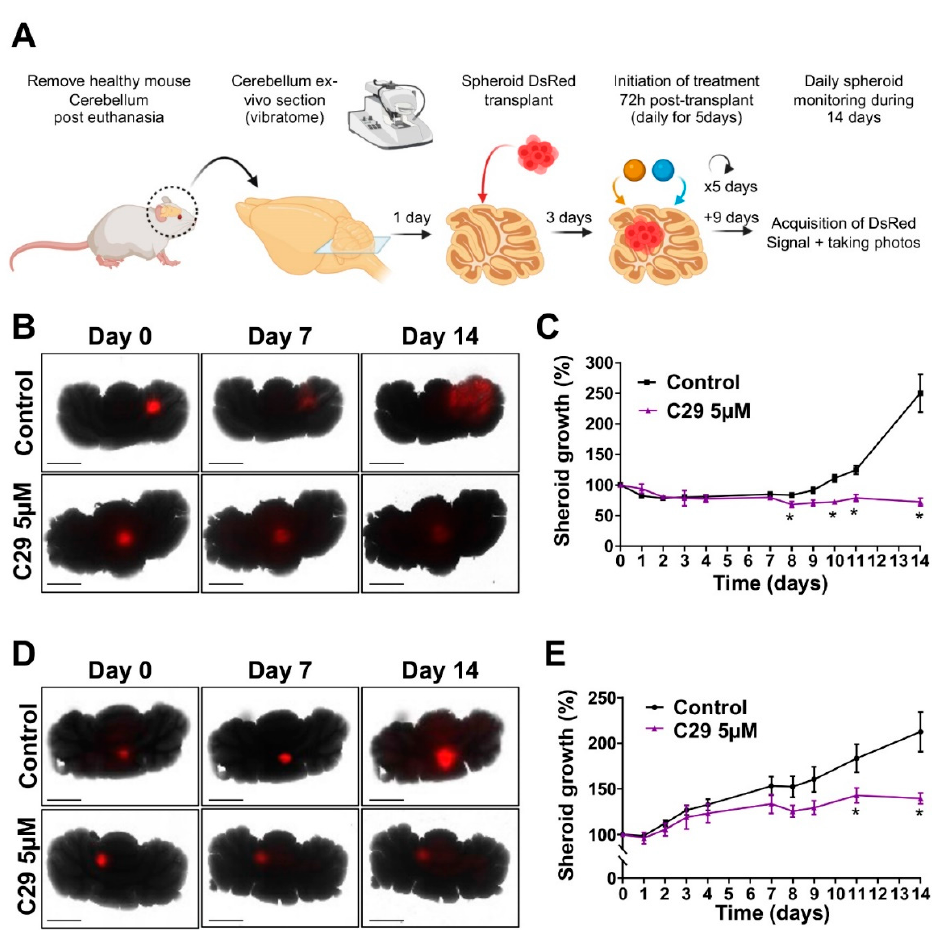
Figure 7. C29 is effective in ex vivo cerebellar organotypic model. ( A ) Experimental setup. ( B , C ) Growth of 3D ONS-76 spheroids expressing DsRed transplanted onto mouse cerebellar slices. Then, 72 h after transplantation, spheroids were treated with 5 µM C29 or control (DMSO) for 5 days to assess the growth and dissemination of spheroids. ( B ) Spheroid growth was monitored by measuring DsRed fluorescence (PheraStar) over 14 days ( C ) Statistics were performed using Student t -test. * p < 0.05, n = 5. ( D , E ) Growth of 3D HD-MB03 spheroids expressing DsRed transplanted onto mouse cerebellar slices. Then, 72 h after transplantation, spheroids were treated with C29 (5 and 10 µM) or control (DMSO) for 5 days. Daily (14 days) images, 30 in total, of spheroid growth in each well (JULISdays) were taken ( D ) Spheroid growth was monitored by measuring DsRed fluorescence (PheraStar) for 14 days ( E ) Scale bar = 250 µM. Statistics were performed using Student t -test. * p < 0.05, n = 5. Table 3. C29 crosses the blood–brain barrier . The table shows the amounts of C29 (ng/mg cerebel- lum) that passed the blood–brain barrier in 10 cerebellar mice previously treated with 100 mg/kg and 10 others treated with 200 mg/kg. In each group, 5 mice were trafficked once, and their cerebel- lum was recovered after 3 h. Five mice were treated daily for 5 days (their cerebellum was recovered 24 h after the last treatment). C29 was determined by HPLC.